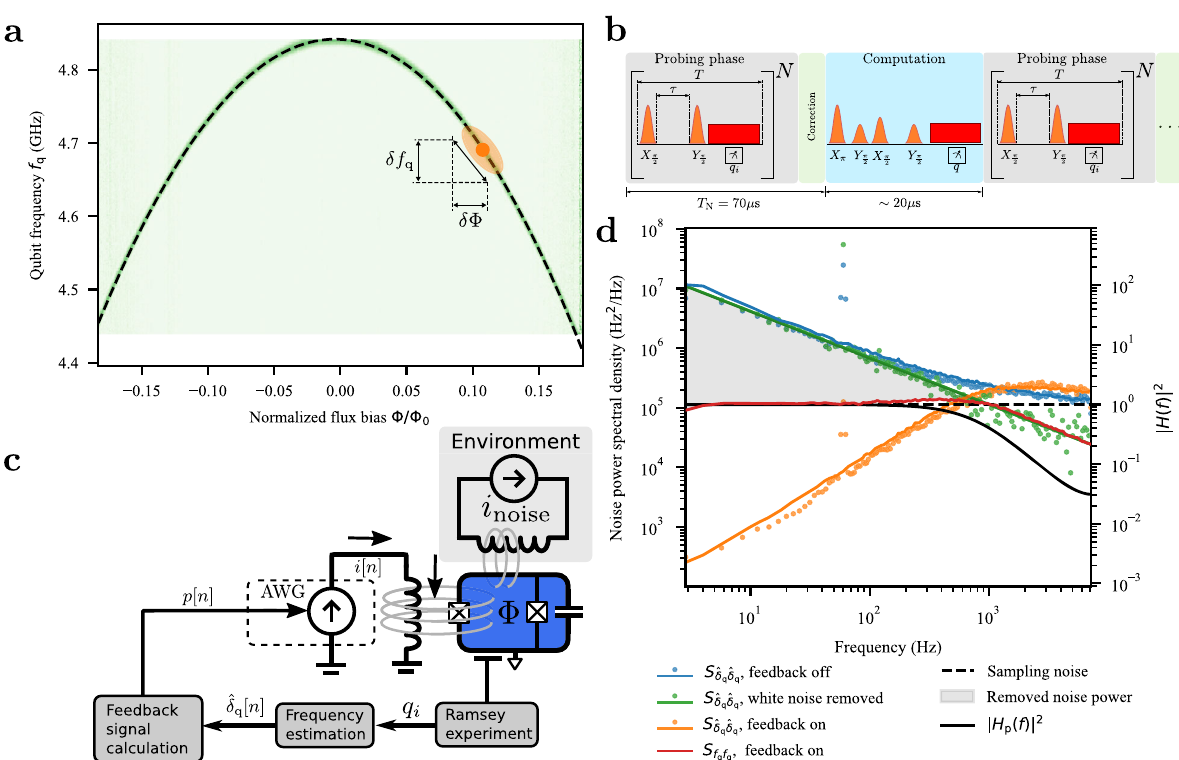
Fig. 1 Qubit frequency power spectral density. a The spectrum of the qubit as a function of fl ux bias. The orange dot shows the fl ux bias point at which the qubit is operated. b Schematic of the frequency estimation pulse sequence (gray) interleaved with the sequence used for computation (light blue). The qubit frequency is adjusted in between (green). c Schematic of the feedback loop. The measurement record q i of a repeated Ramsey experiment is used to estimate the qubit frequency offset ^ δ q ½ n (cid:3) subject to a noisy environment i noise . The feedback signal p [ n ] controls an AWG that produces current i [ n ] to cancel the fl uctuations in the qubit frequency. d Power spectral density of the qubit frequency fl uctuations. The blue dots (line) show the measured (simulated) spectral density of the qubit frequency fl uctuations estimated from N = 20 Ramsey experiments S ^ δ noise (dashed black line). The spectrum with the sampling noise suppressed using cross-correlation between consecutive samples is shown with green dots along with a fi t (green line). Orange dots (line) are the measured (simulated) power spectral density of the error signal ^ δ q ½ n (cid:3) with the feedback activated. The simulated power spectral density of the actual qubit frequency fl uctuations f q ( t ) is shown with a solid red line. The gray background describes the noise power removed by the feedback. The frequency response of the feedback signal is overlaid in the plot with a solid black